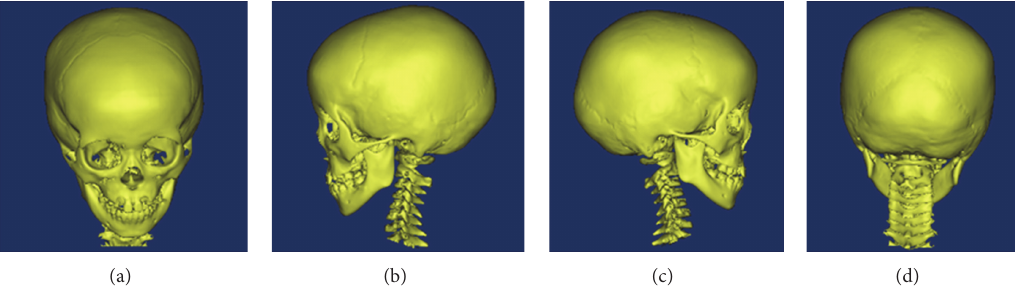
Figure 18: Each view drawing on the 3D finite element model in of cranial cavity.